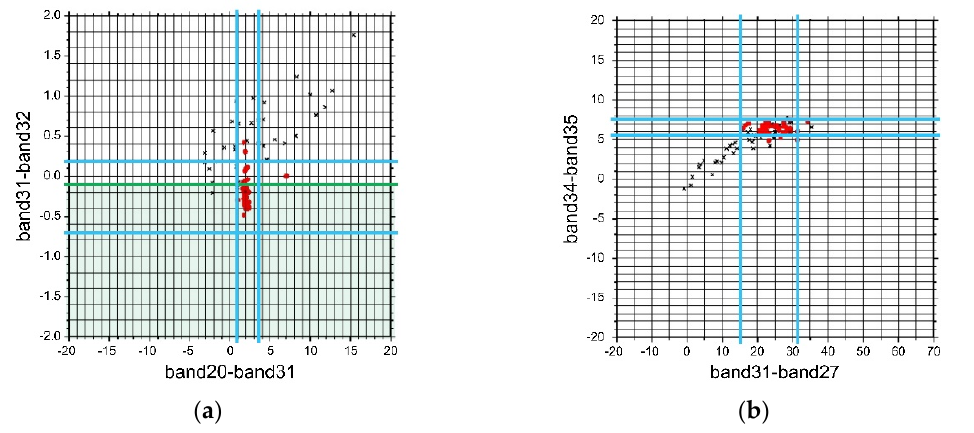
Figure 6. Scatter diagrams of BTDs for cloud discrimination at Tsukuba, Japan. ( a ) BTD 31–32 vs. BTD 20–31 ; ( b ) BTD 34–35 vs. BTD 31–27 . Blue lines in panels ( a ) and ( b ) correspond to the upper or lower threshold values in BTDs between clear and cloud pixels for the proposed method in this study. Green line in panel ( a ) indicates the threshold of the previous Noguchi method. Below this line, it is determined by clear pixels. Red and black symbols correspond to clear and cloud pixels distinguished by LiDAR data.